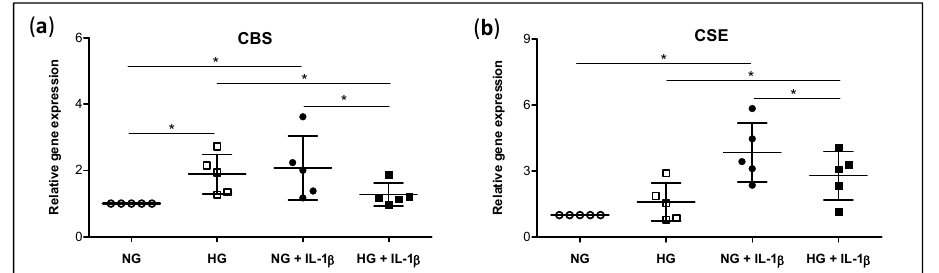
Figure 4. IL-1 β -stimulated expression of H 2 S synthesising enzymes under high glucose environment. OA human chondrocytes were incubated in growth media with normal (NG) or high (HG) levels of glucose in the presence or absence of IL-1β. Thereafter, the gene expression of ( a ) CBS and ( b ) CSE was analysed. Values are mean ± SEM (n = 5). * p ≤ 0.05 analysed by the Wilcoxon test. CBS, cystathionine β -synthase; CSE, cystathionine γ